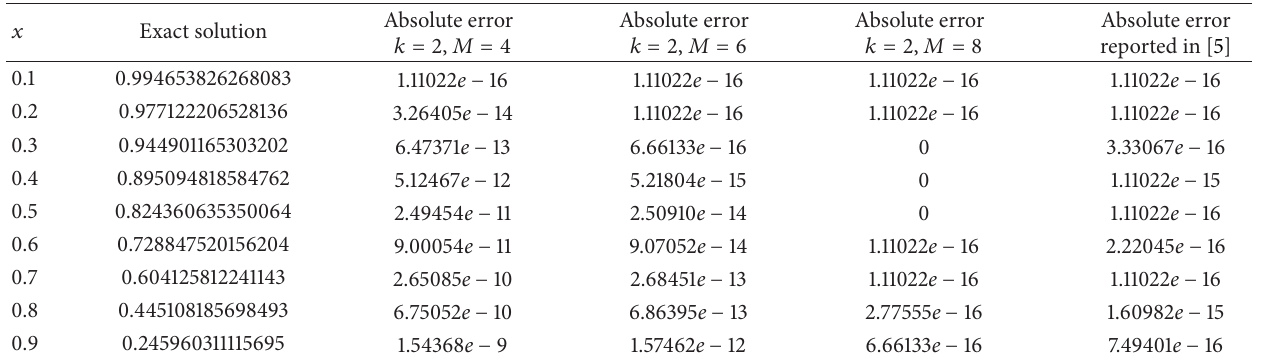
Table 5: Comparison of numerical results for Example